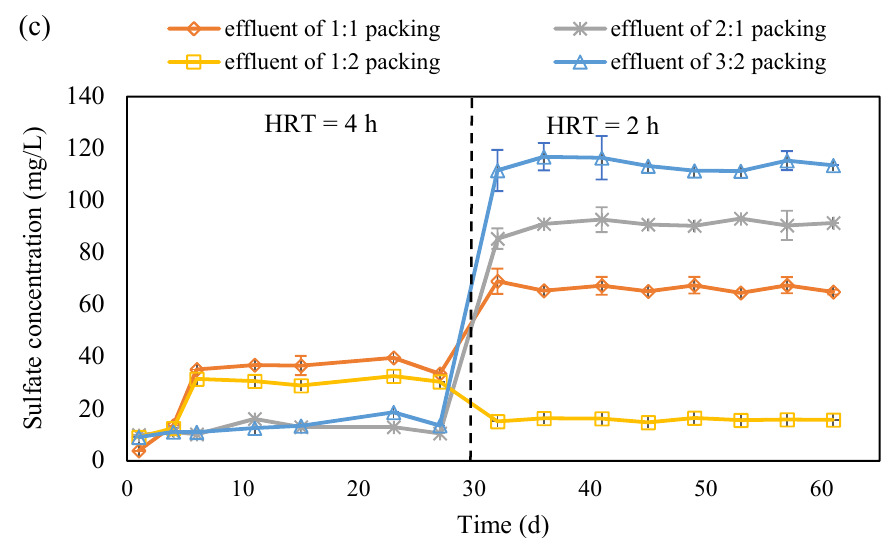
Figure 4. The concentration variation in NO 3 − -N ( a ), NO 2 − -N ( b ) and SO 4 2 − ( c ) in the effluent of S 0 and corncob separated packing system (S 0 presents the element sulfur; NO 3 − -N presents the nitrate nitrogen; NO 2 − -N presents the nitrite nitrogen; HRT presents the hydraulic retention time; ‘effluent of 1:1 packing’, ‘effluent of 2:1 packing’, ‘effluent of 1:2 packing’ and ‘effluent of 3:2 packing’ present the effluent collected from the reactor packed with corncob and S 0 with a ratio of 1:1, 2:1, 1:2 and 3:2, respectively).